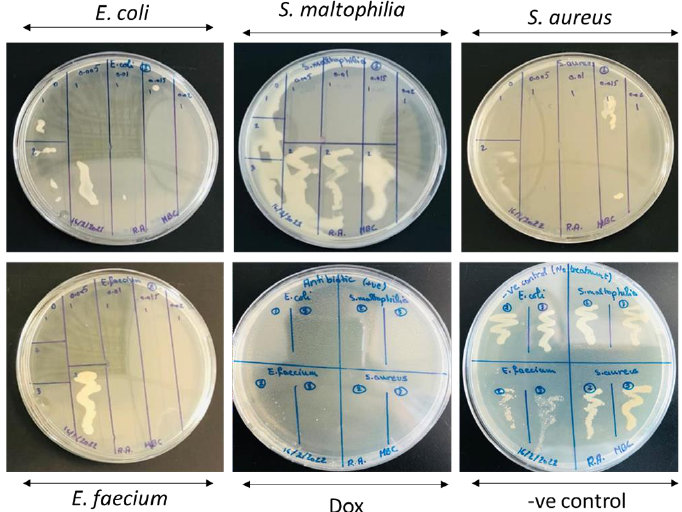
Figure A3. MBC results of the undoped and Mg-doped CuO NPs against four bacterial isolates.